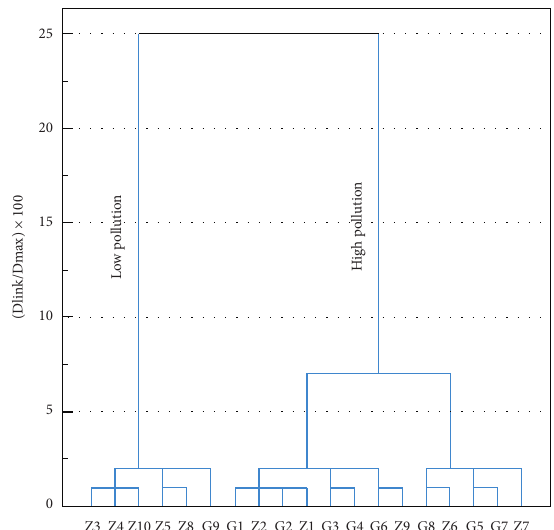
Figure 4: Spatial cluster analysis of pollutants in